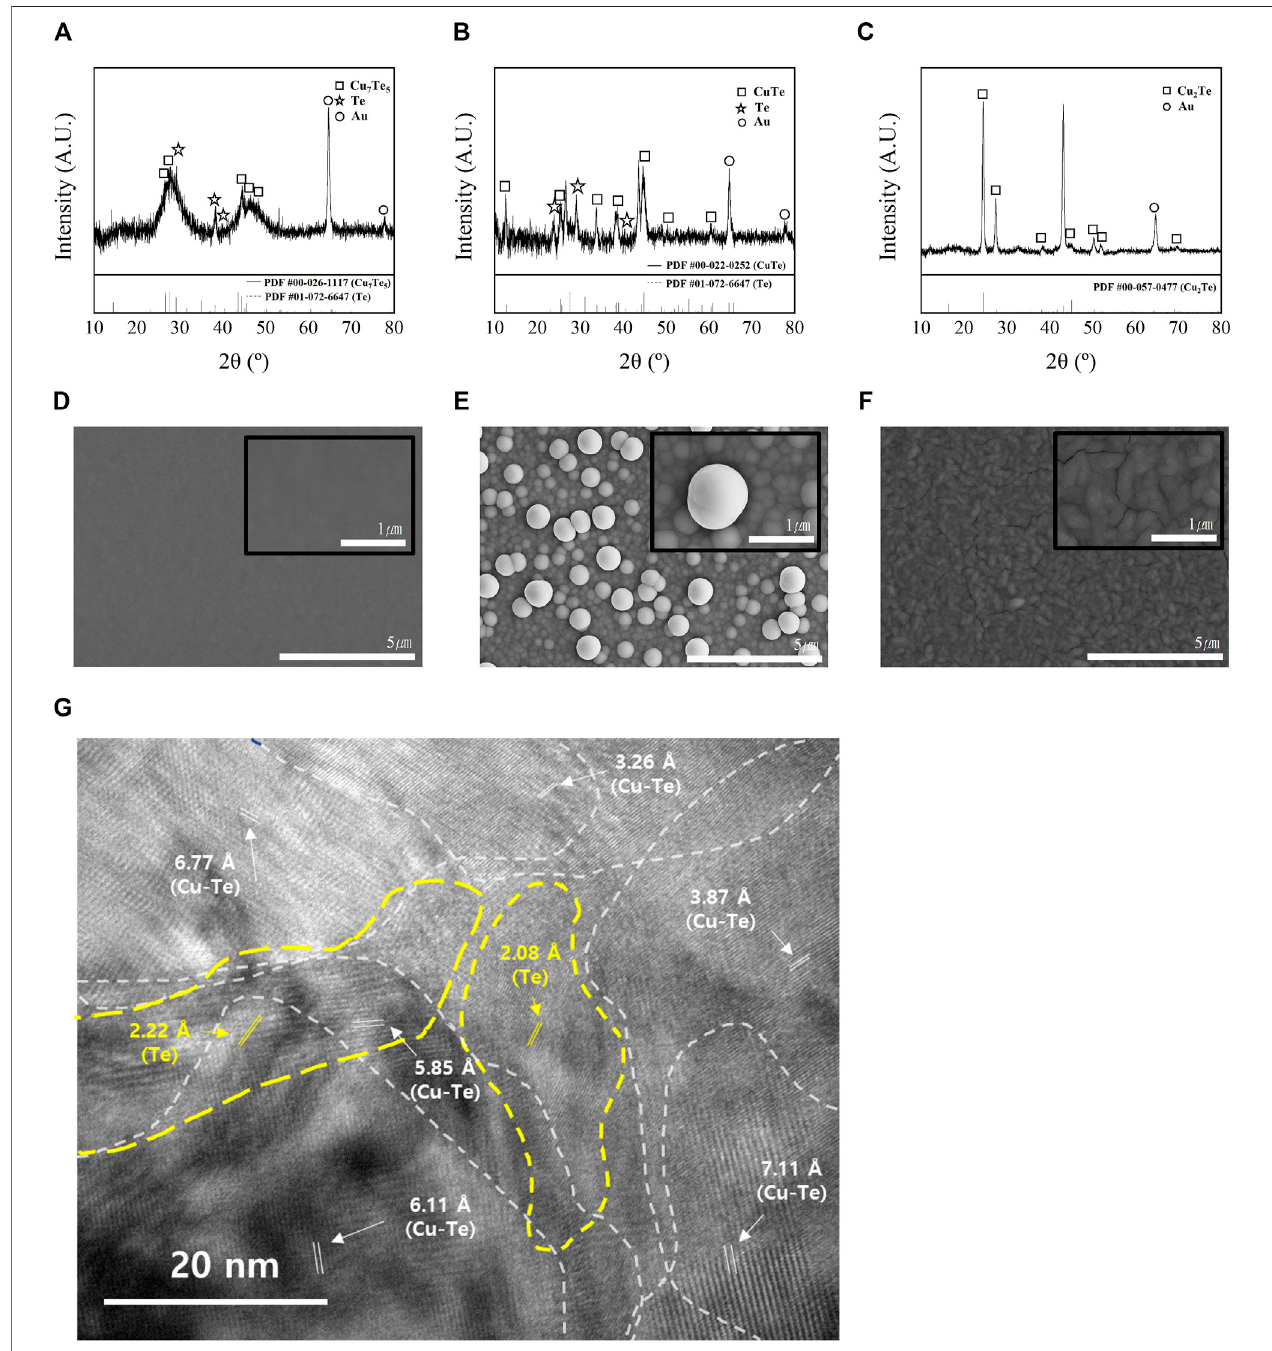
FIGURE 3 | XRD patterns thin fi lms formed at Cu/Te compositional ratios of (A) 0.5 (PDF #00-026-1117: Cu 7 Te 5 , PDF #01-072-6647: Te), (B) 1 (PDF #00-022- 0252:CuTe), (C) 2(PDF#00-057-0477:Cu 2 Te),andSEMimages[10000x,50000x(insets)]ofthin fi lms(1 mm)atCu/Tecompositionalratiosof (D) 0.5(Cu 7 Te 5 +Te), (E) 1 (CuTe), (F) 2 (Cu 2 Te). (G) HR-TEM (250kx) image of thin fi lms formed at a Cu/Te compositional ratio of 0.5.